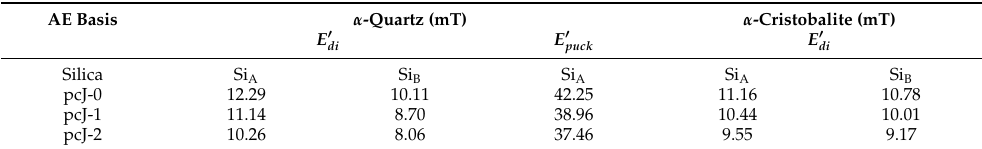
Table 4. Calculated isotropic hyperfine coupling constants employing the pseudopotential structures and the all-electron wavefunction with the PBE0 functional, as the quality of the pcJ basis sets systematically